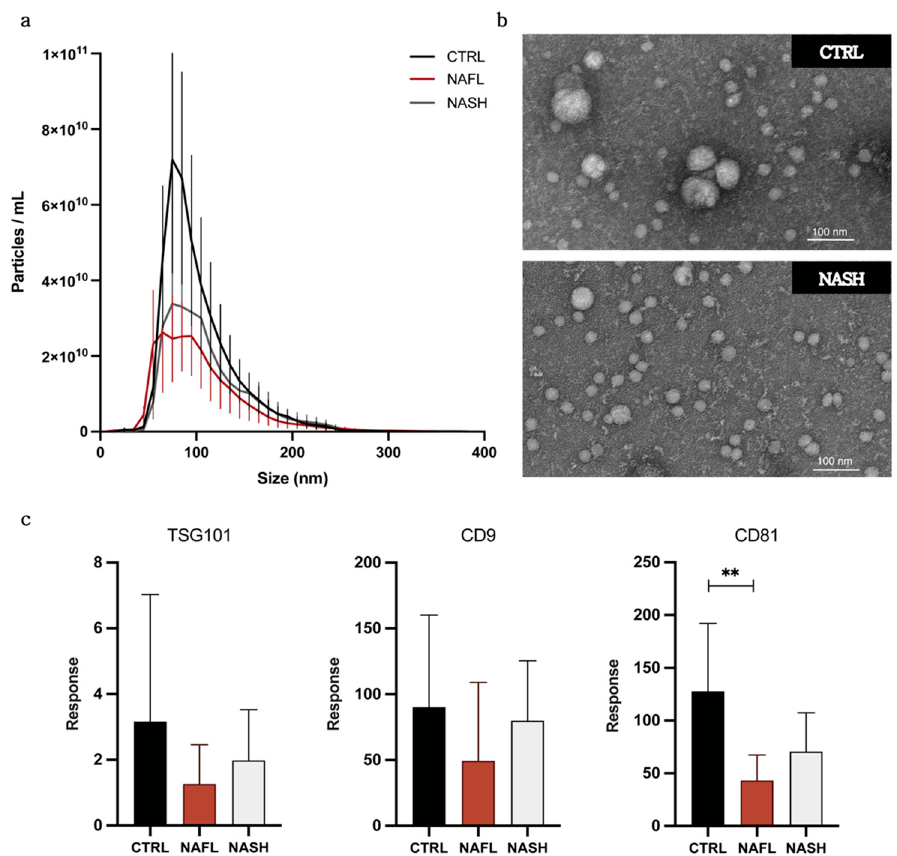
Figure 2. Characterisation of global circulating EV isolated from control, NAFL, and NASH subjects. ( a ) Particle concentration and size distribution by nanoparticle tracking analysis (NTA) ( n = 5). Error bars denote SEM. ( b ) Representative TEM images of NASH patient and control global EVs. ( c ) Relative abundance of EV protein markers determined by mass spectrometry. Error bars denote SD. ** p ≤ 0.01.